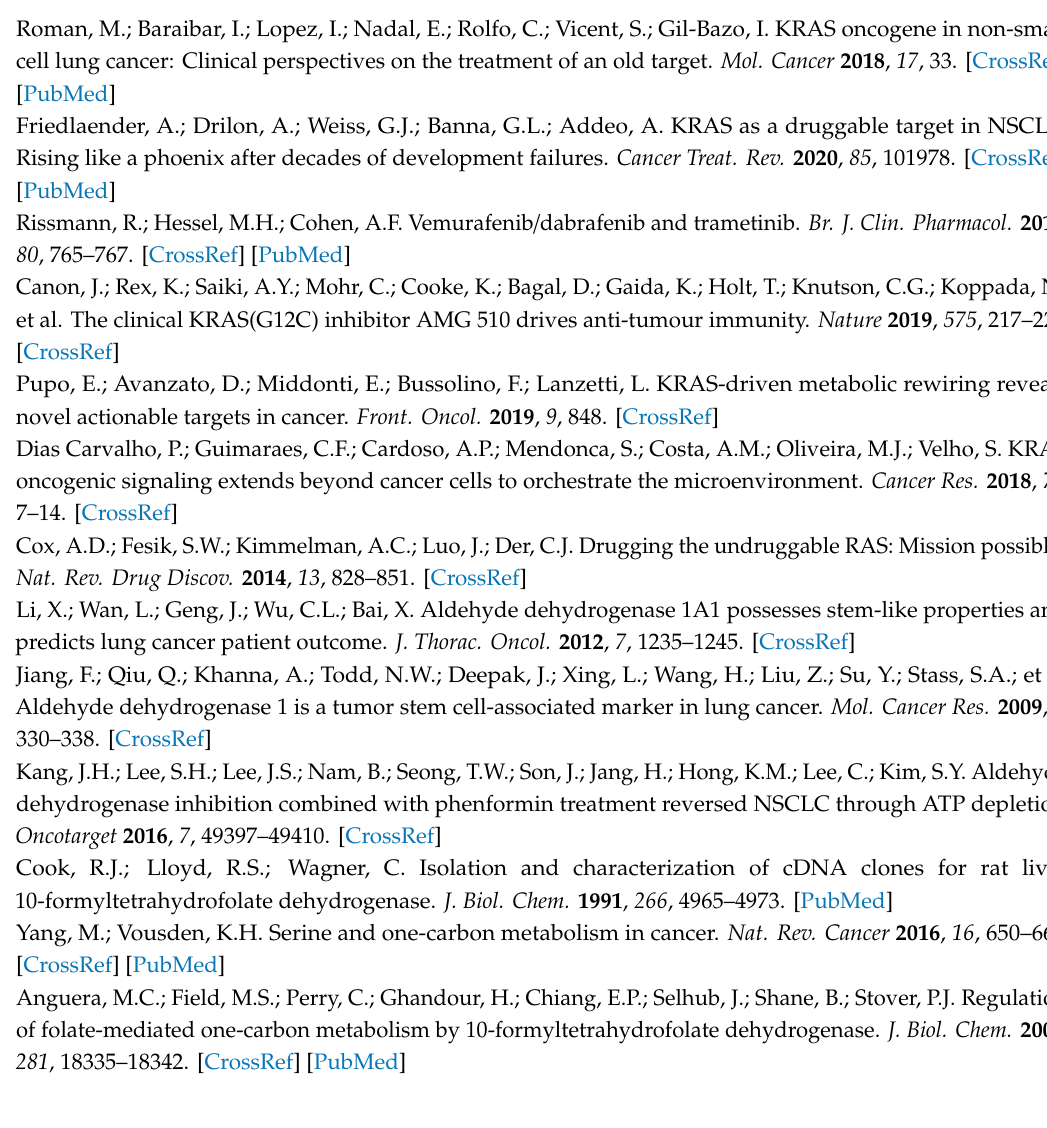
Figure S1: Detailed information about western blot in Figure 1, Figure S2: Detailed information about western blot in Figure